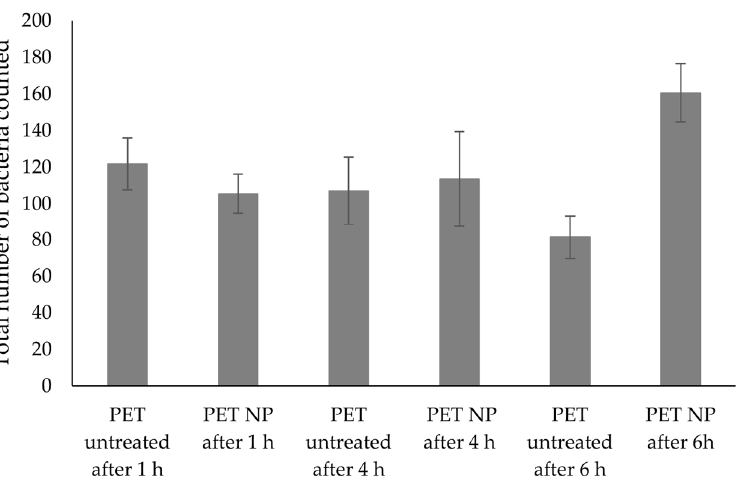
Figure 8. Number of bacteria attached to untreated and treated PET samples, after incubation for 1, 4 and 6 h. Data are presented as means ± SD (n = 6).